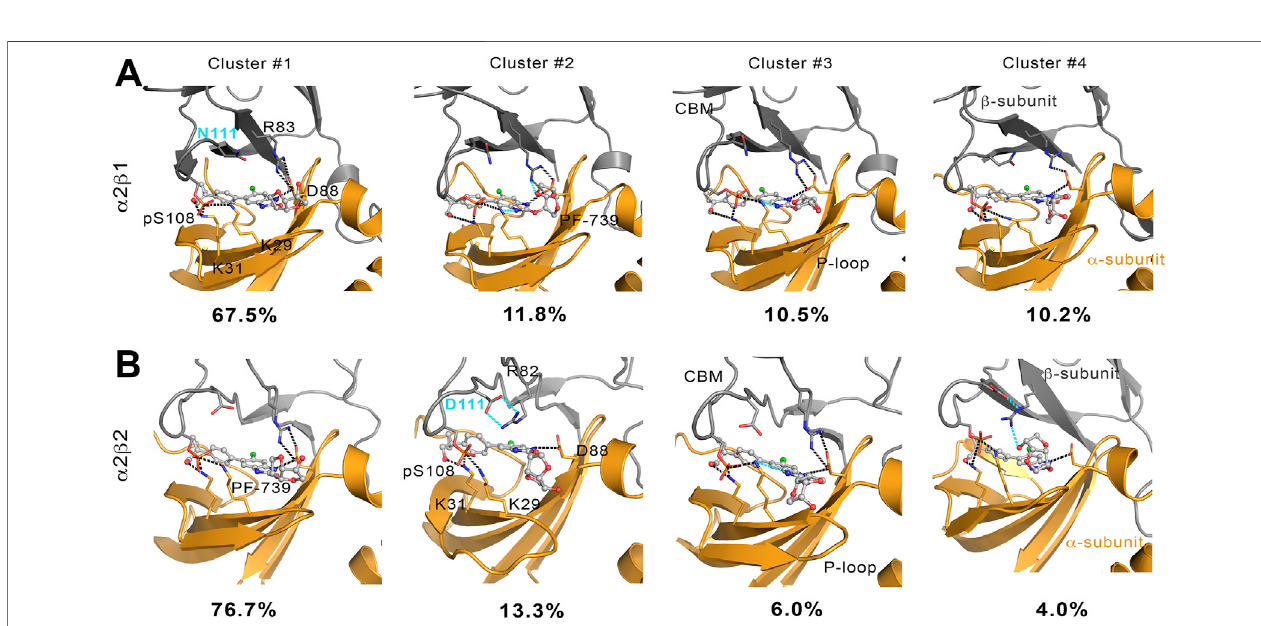
FIGURE 8 | Representation of main interactions between the CBM, P-loop and PF-739 for holo states of (A) α 2 β 1 and (B) α 2 β 2 species for the four clusters obtainedalongthelast500 nsofsimulation ofeachreplica.The α -subunitisshowninorangecartoon,whilethe β -subunitisshowningreycartoons.PF-739isshownin greyballandsticksintheADaMsite.SelectedpolarinteractionsmaintainedthroughalltheMDsimulationsandclustersarehighlightedinblackdashedlines,whilethose formed in speci fi c clusters are shown in cyan.